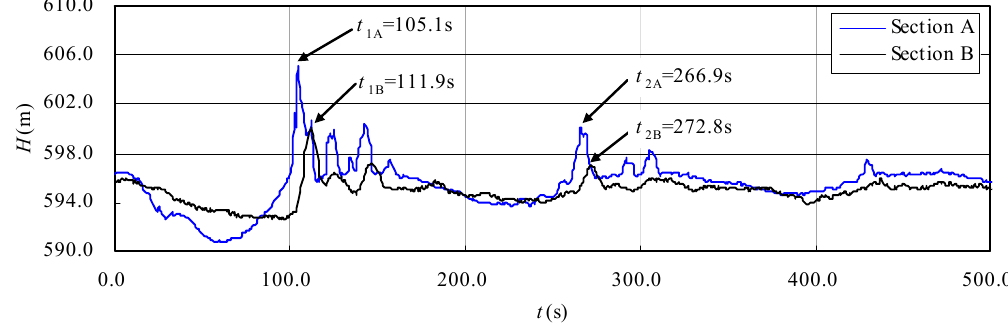
Figure 6. Time histories of the piezometric head at sections A and B under case C1.